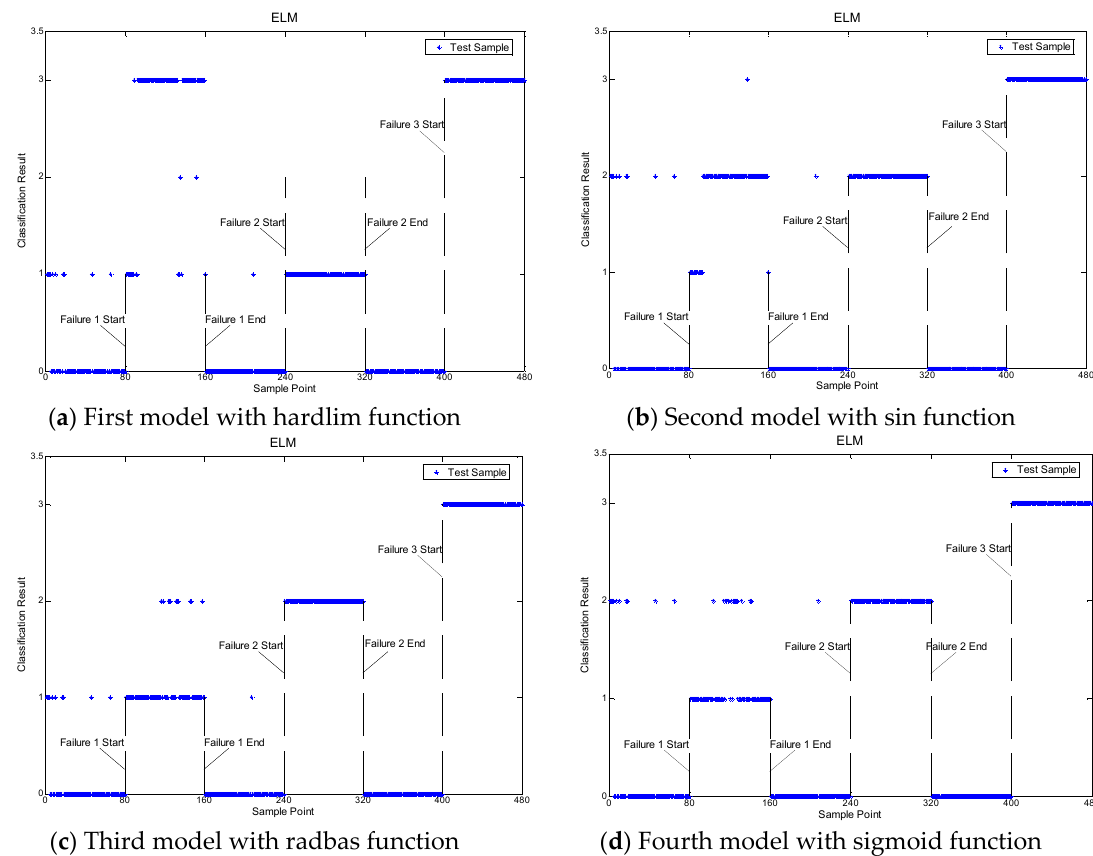
Figure 8. Classification result with extreme learning machine (ELM).